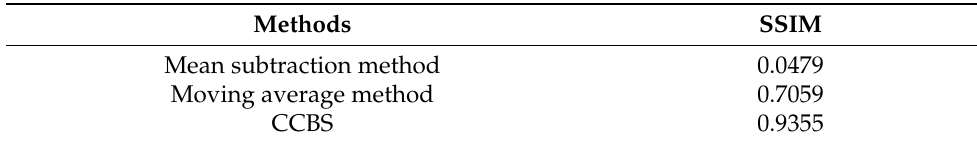
Table 1. Performance comparison.